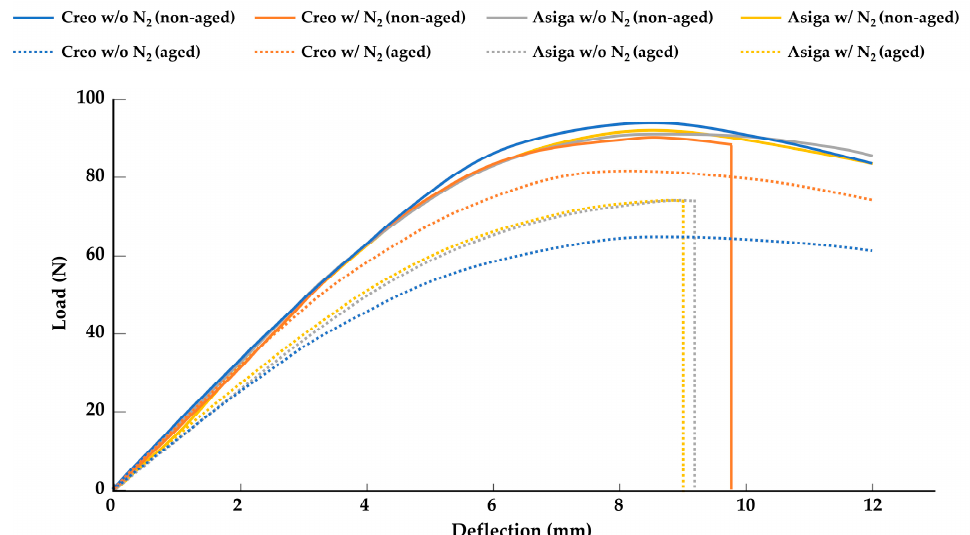
Table 2. Mean value and standard deviation of flexural strength, flexural modulus, ratio of broken specimens during three-point bending test, VHN, and fracture toughness, and results of one-way ANOVA statistical analysis and Chi-squared test.